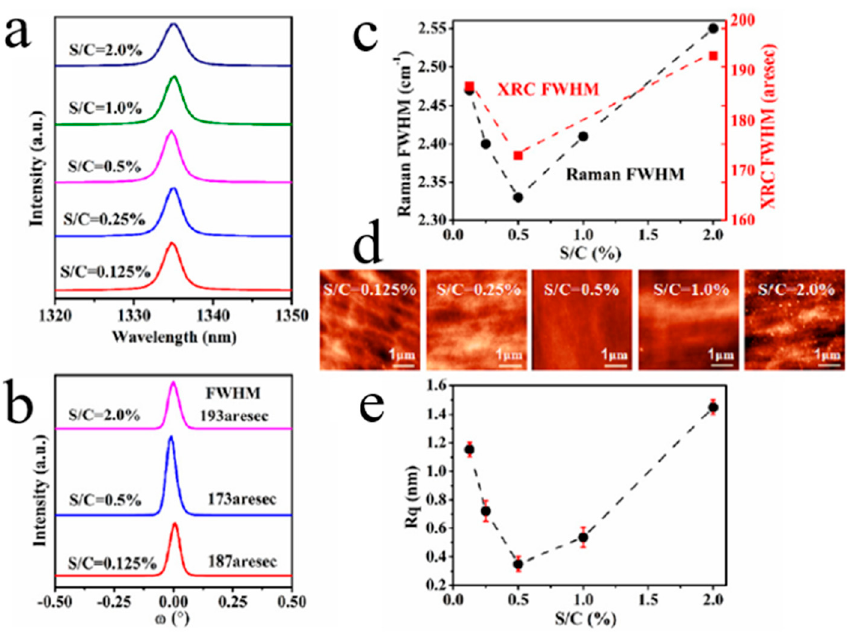
Figure 5. Boron/sulfur co-doped diamond thin films with the different S/C gas proportion: ( a ) Raman pattern. ( b ) X-ray rocking curves (XRCs). ( c ) Full width at half maximum of the Raman pattern and XRCs. ( d ) Atomic force microscopy (AFM) image (5 × 5 µ m 2 ). ( e ) Root mean square (RMS) surface roughness (Rq) [63].